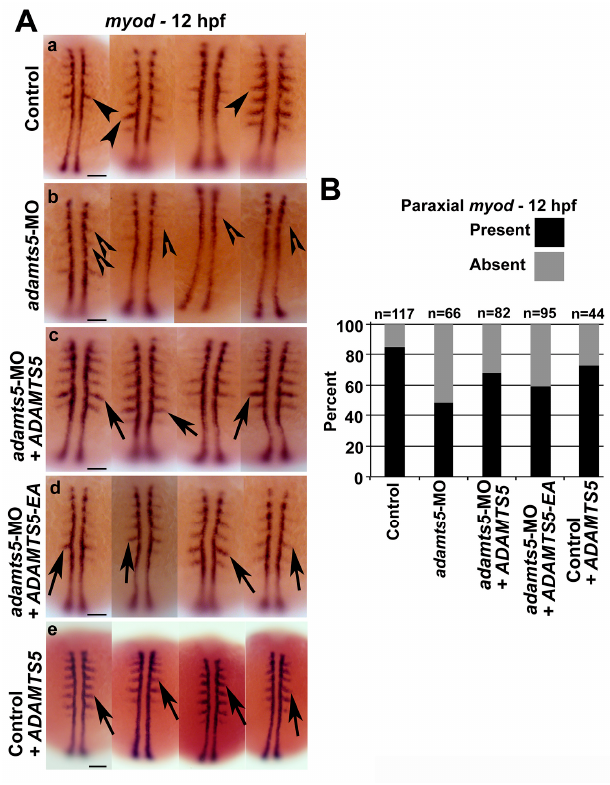
Figure 3. Loss of paraxial mesodermal myod expression in adamts5 morphant embryos. ( A ) Expression of adaxial and paraxial myod in 12 hpf embryos injected with control MO ( a , arrowheads), with adamts5 morphant embryos showing substantial loss of paraxial expression ( b , open arrowheads), as well as mild loss of paraxial myod expression ( b , open arrowheads). Rescue of paraxial myod expression in adamts5 morphants co-injected with mRNA encoding wild-type ( c , arrows) or catalytically-inactive E 411 A ( d , arrows) ADAMTS5. Control embryos injected with ADAMTS5 mRNA encoding wild-type ADAMTS5 show unaffected myod expression in paraxial mesoderm ( e , arrows). Scale bar = 100 µ m; ( B ) Quantitation of embryos showing present or absent myod patterning represented in ( A ).